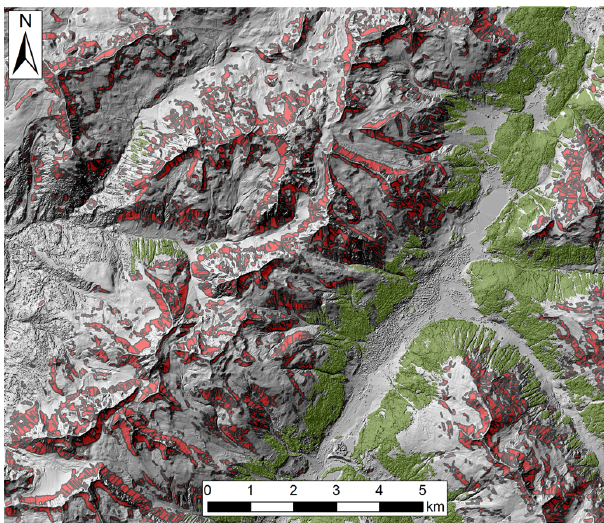
Fig. 7. Result of the automated potential avalanche release zone identification algorithm (red) for the entire investigation area Davos with a DEM resample size of 5m, a curvature threshold of 3 and a ruggedness threshold of 0.03. The forest information derived from the topographic map 1 : 25000 is shown in